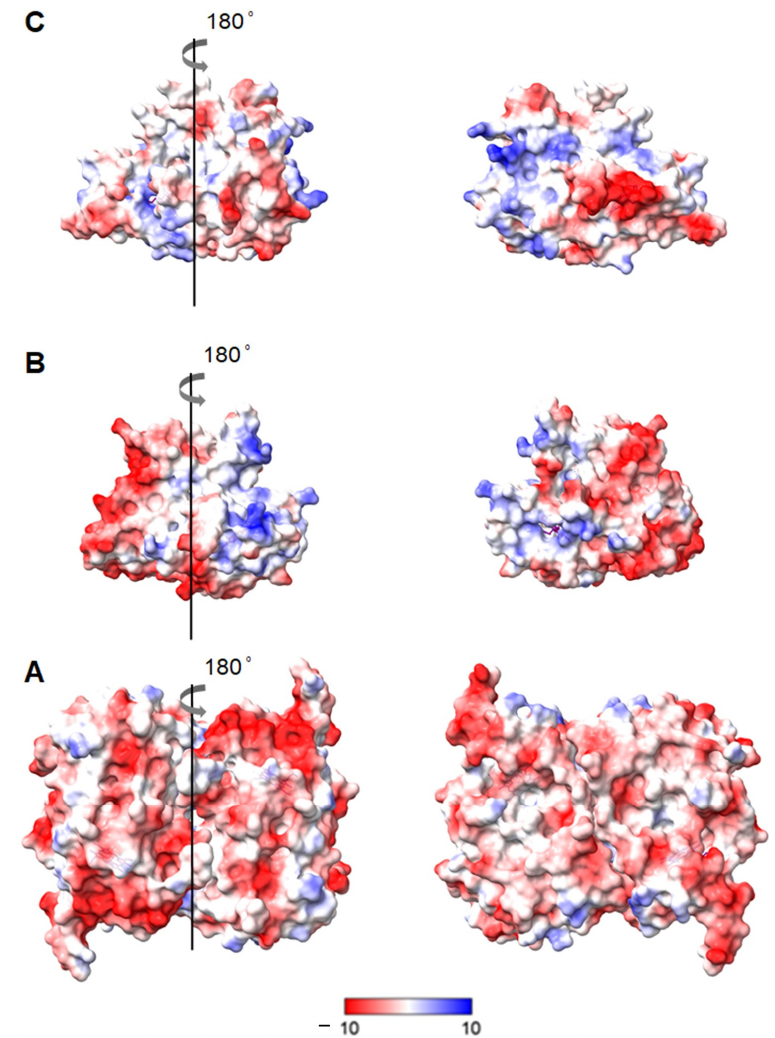
Figure 1. Electrostatic surface potential of ( A ) Cellulomonas bogoriensis (CboDyP) (dimer; PDB code: 6QZO), ( B ) Thermobifida fusca (TfuDyP) (monomer; PDB code: 5FW4) and ( C ) Streptomyces coelicor (ScoDyP) (monomer; PDB code: 4GT2). Surface potential: − 10 to +10 kT/e; the red colour indicates negatively charged regions; the blue colour indicates positively charged regions. Figures were prepared with ChimeraX [25].